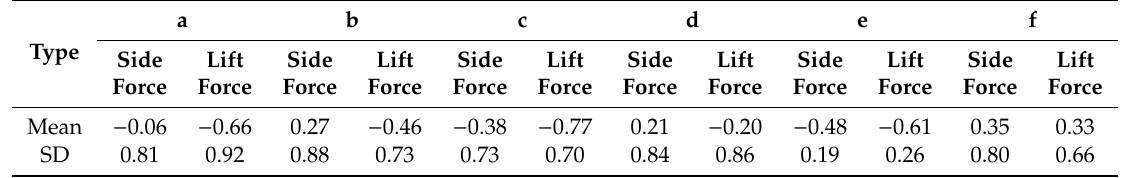
Figure 4. Scatter diagrams of changes in the lift and side forces acting on the balls in the wind tunnel test. In this figure, ( a , b ) represent the Face A and B orientation of the new Mikasa volleyball, respectively; ( c , d ) represent the Face A and B orientations of the old Mikasa volleyball, respectively; and ( e , f ) represent the Face A and B orientation of the old Molten volleyball, respectively (10 s, wind velocity of 15 m/s). Table 1. Mean and standard deviation (SD) of the lift and side forces acting on the respective volleyballs (10 s, wind velocity of 15 m/s).